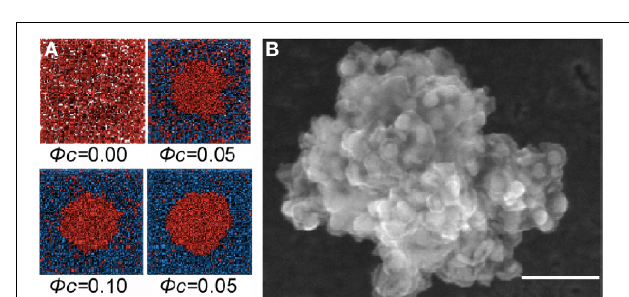
FIGURE 2 | Formation of protein clusters in a crowded solution. (A) Molecular Dynamics simulation of Lennard-Jones particles (red) shows clustering induced by crowding particles (blue) which is more pronounced at higher volume fractions ( φ c ) of crowder (reproduced from [24] with permission from Elsevier, © 2012). (B) A cluster of monoclonal antibody molecules in a solution with trehalose as crowder (scanning electron microscopy); similar clusters form using polyethylene glycol as crowder. Scale bar 100 μ m (reproduced from [26] with permission from the American Chemical Society, ©